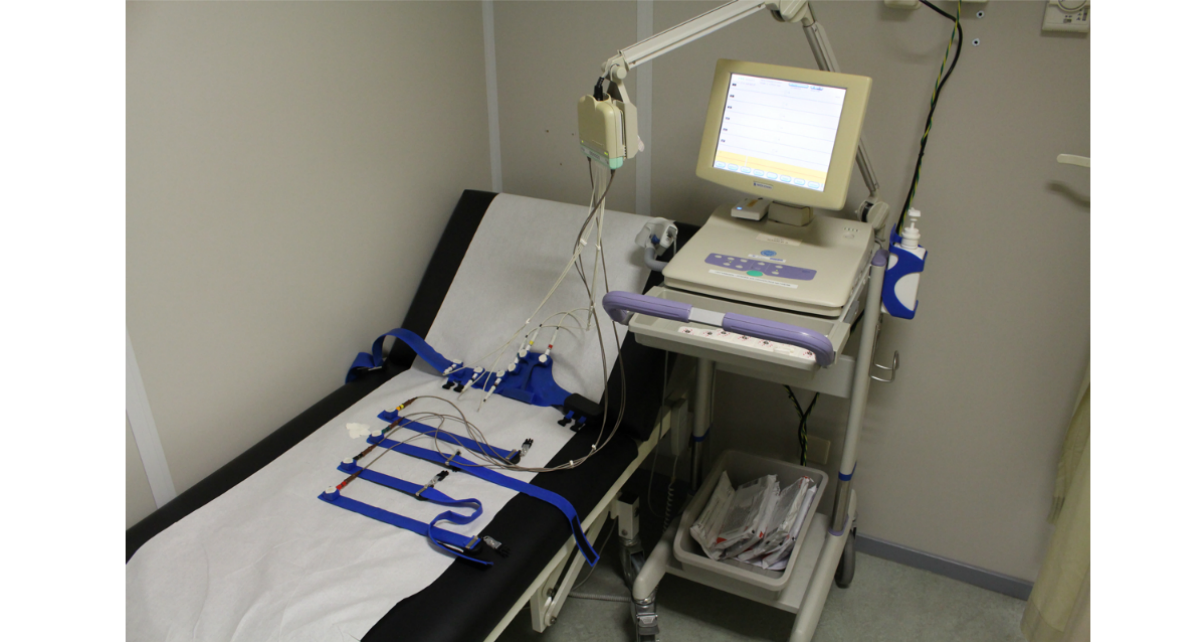
Figure 11. The standard 12-lead monitoring equipment connected to the prototype.